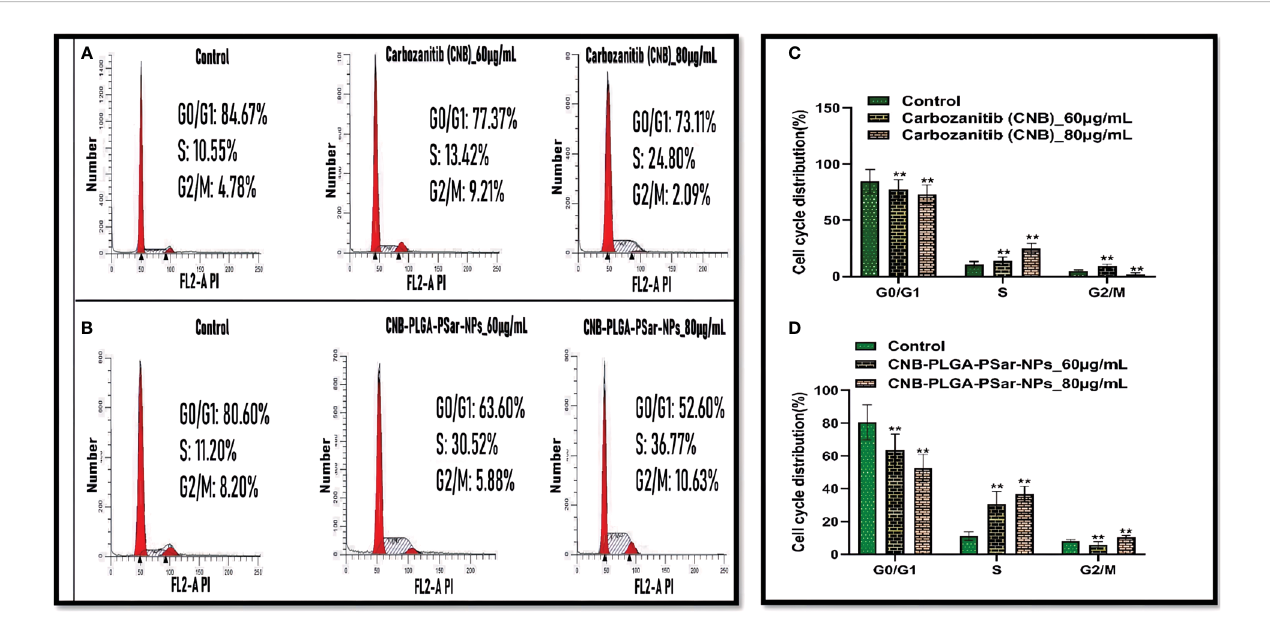
FIGURE 5 Flow cytometry was used to analyse cell cycle distribution and DNA content in HepG2 cells treated by CNB-loaded CNB-PLGA-PSar-NPs and free CNB for 48 h (A, B) The cells were stained with PI and the cell cycle stage was de fi ned by DNA content. (C, D) The percentages of cell populations in the G0/ G1, S, and G2/M phases was determined by gating during the fl ow cytometry experiment for control, free CNB and CNB-loaded CNB-PLGA-PSar-NPs at 60 µg/mL & 80 µg/mL concentration. These experiments are performed thrice mean ± SD; n= 3, **p <0.05, where untreated group is considered as